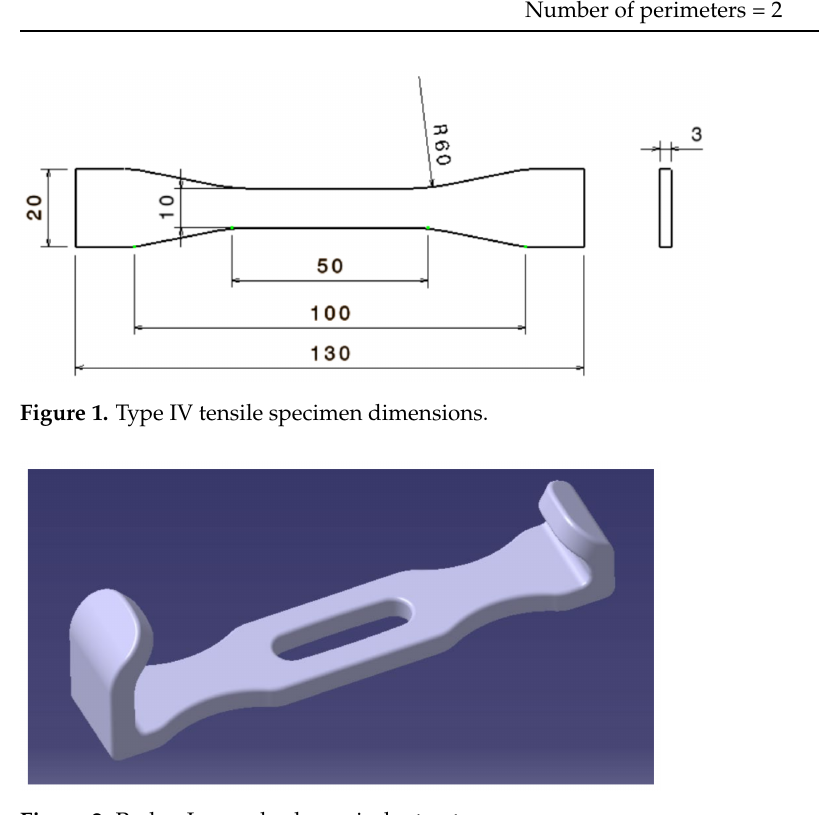
Figure 2. Parker Langenbeck surgical